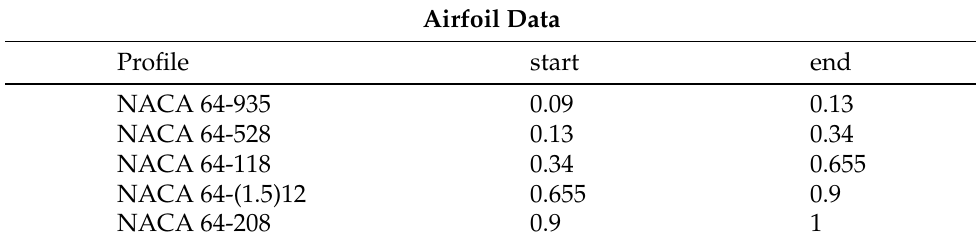
Table 5. XV-15 Blade airfoil distribution